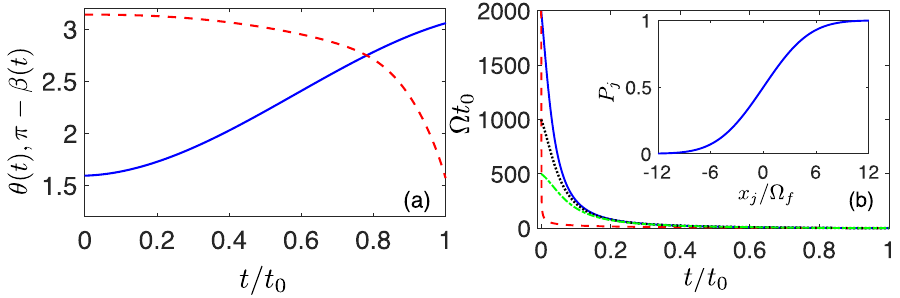
β (dashed-red), where θ is interpolated by a polynomial − 5 2000 , with ǫ 2 10 1 and κ . ( b ) The − f = = = × 1000 (dotted-black) and κ 500 (dot-dashed- = =